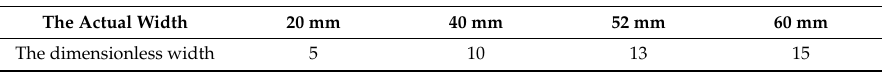
Figure 3. Illustration of plexiglass water tank and measuring region: ( a ) Structure of plexiglass water tank; ( b ) Vertical plane; ( c ) Horizontal plane. Table 3. The doubled-walled confined width.